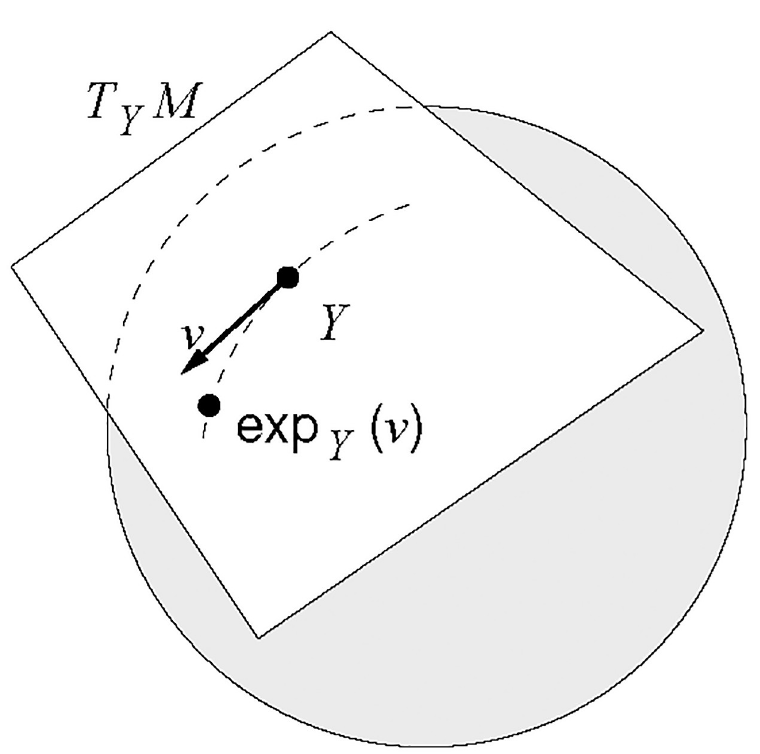
Fig 7. Tangent space at point Y on a sphere. A geometrical view of the tangent plane to a Riemannian manifold M ( S 3( k − 1) in our case) at a point Y , together with the exponential map.